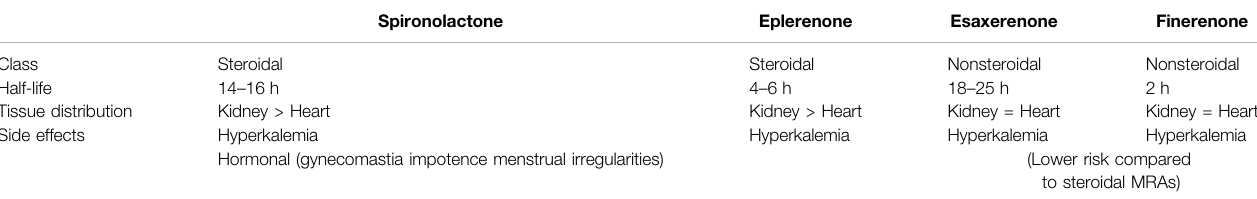
TABLE1| DifferencesbetweensteroidalandnonsteroidalMRAs.EachMRAhasdifferenthalf-lifeandtissuedistribution(Lentinietal.,2016;Agarwaletal.,2021;Wanetal., 2021).Bothofthosedrugscancausehyperkalemia.However,nonsteroidalMRAsarethoughttohavelessriskofhyperkalemiabecauseoftheirequaltissuedistribution in kidney and heart (Agarwal et al.,